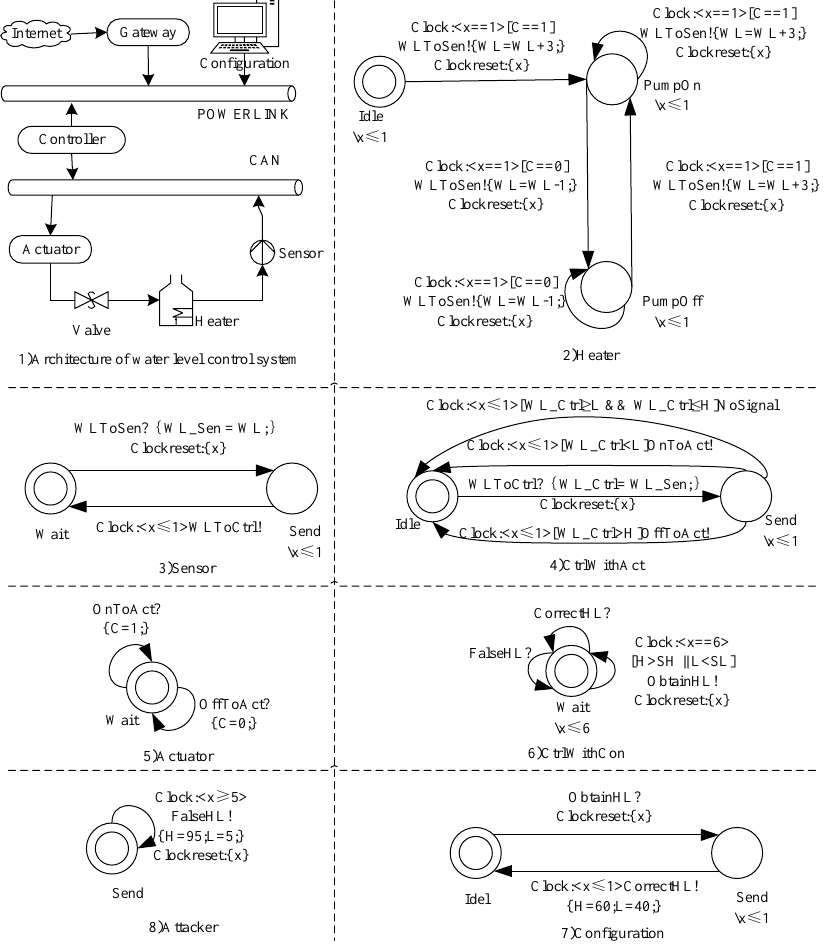
Figure 9. Architecture and timed automata models of water disposal